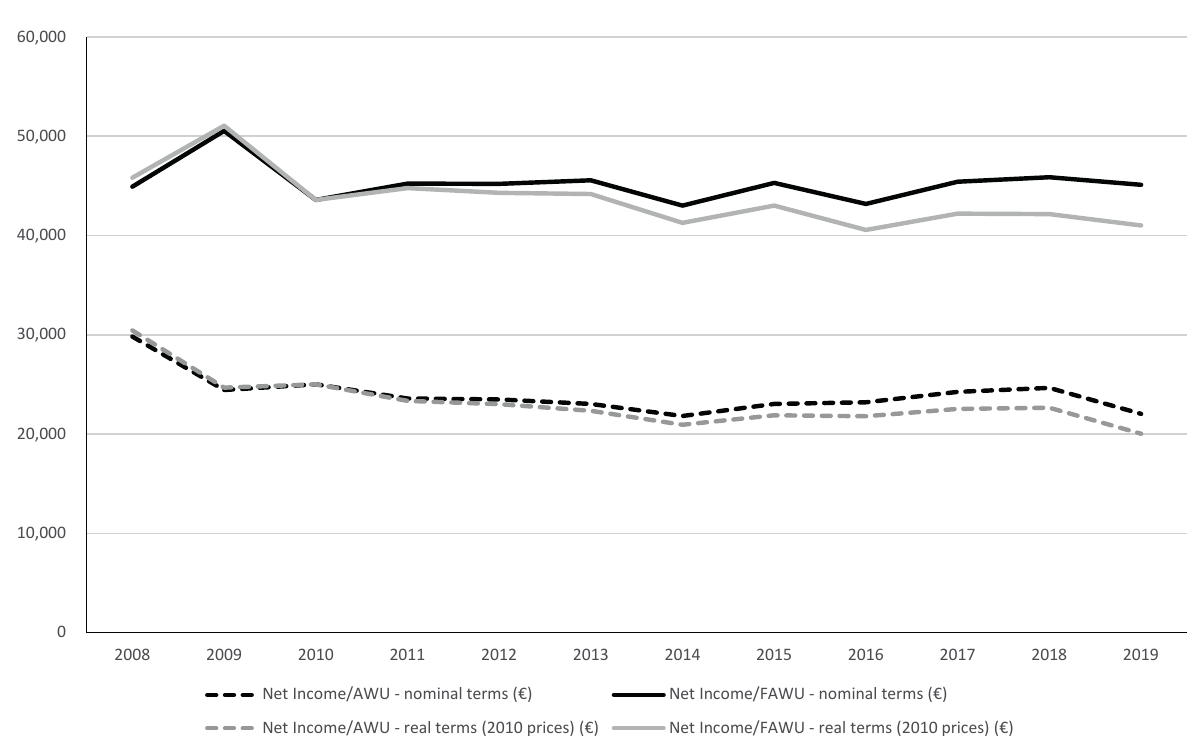
Figure 6. Evolution the farm net income per (F)AWU over the 2008-2019 period within the Italian FADN balanced sample.